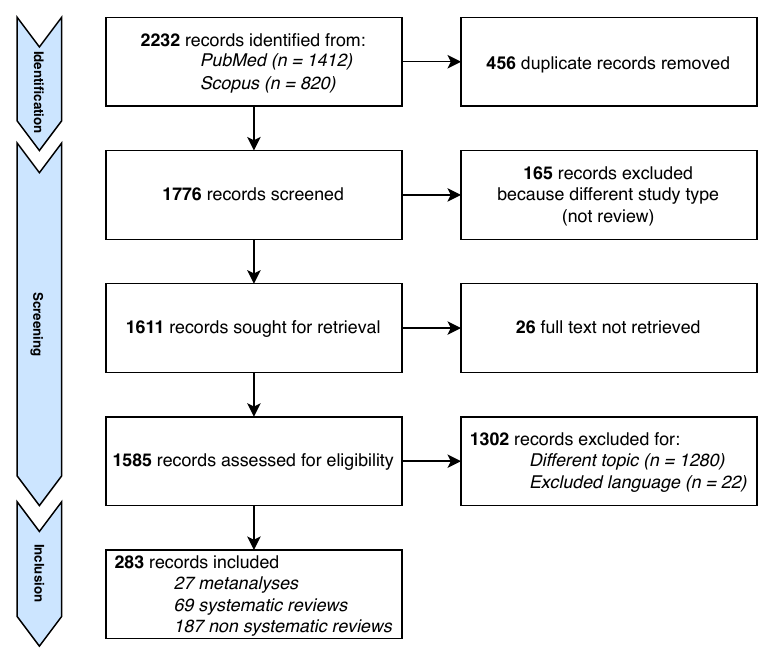
Figure 2. PRISMA flowchart.